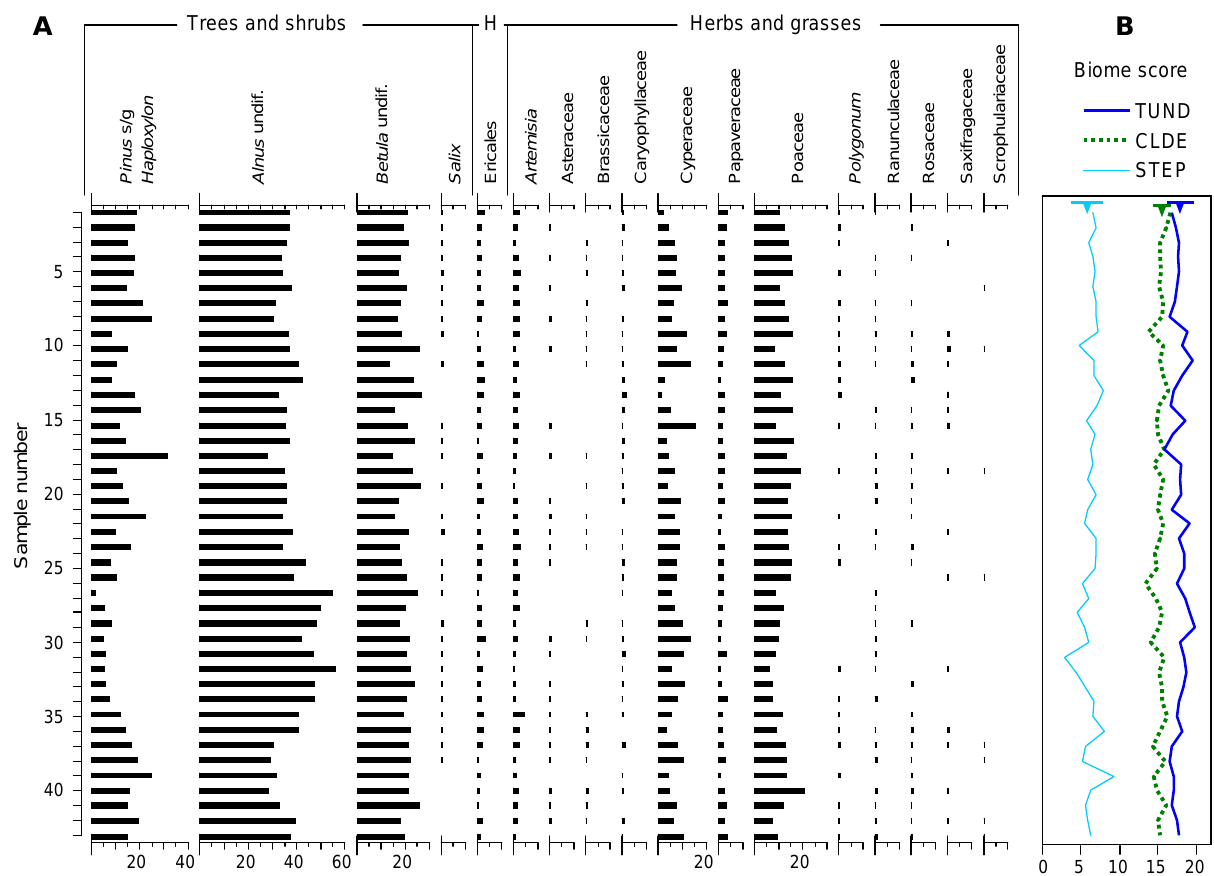
Fig. 2. Diagram of modern data from Lake El’gygytgyn: (A) summary pollen percentage diagram of the 43 modern surface pollen spectra (pollen analyst T. Matrosova), and (B) calculated affinity scores of individual biomes that dominated in the study area during the late Quaternary. Triangles indicate the modern mean score value of each respective biome, and horizontal bars indicate the 95% uncertainty ranges (2 standard deviations away from the mean). The diagram was constructed using Tilia/Tilia-Graph/TGView software (Grimm, 1993, 2004). Percentages for individual terrestrial pollen taxa at each level were calculated from the sum of arboreal and non-arboreal pollen. Only taxa that exceed the 0.5% threshold are shown. H indicates heath. Biome names are abbreviated as follows: STEP – cold steppe, TUND – tundra, and CLDE – cold deciduous